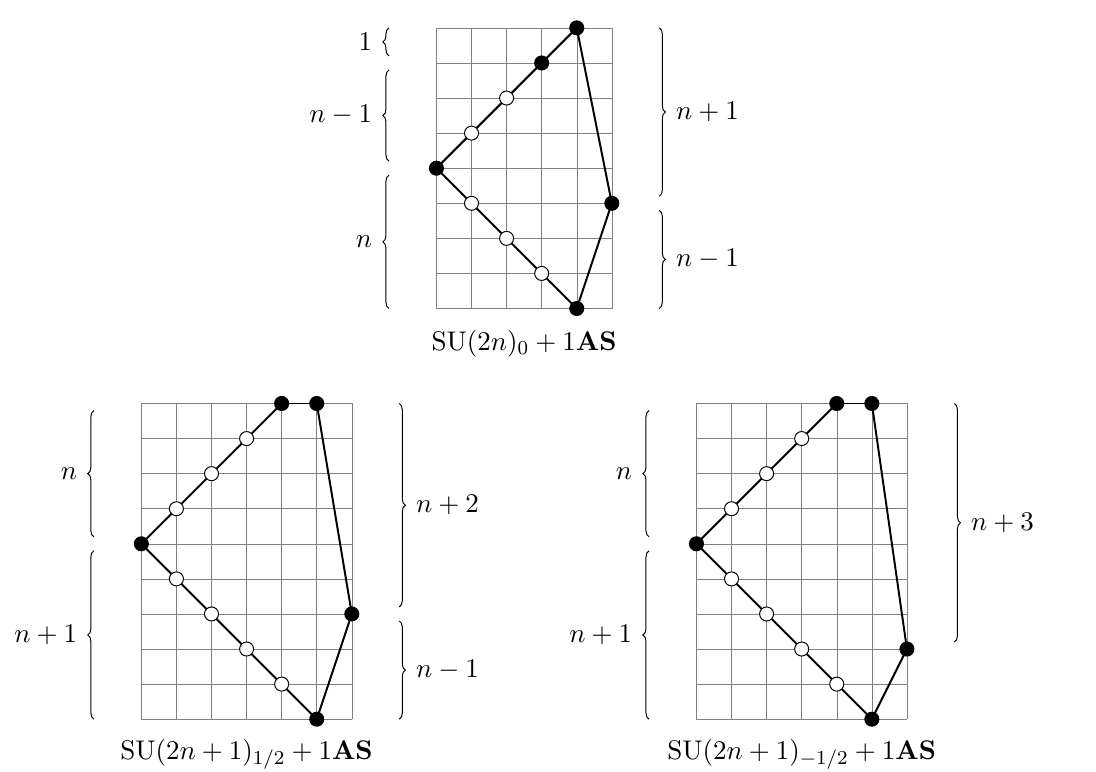
Figure 2 . Toric polygons for SU( N ) k + 1 AS for the lowest possible values of the Chern-Simons level, | k | < 1 . We have to distinguish between the cases where N = 2 n is even and N = 2 n + 1 is odd. The polygons presented here can be deduced from the brane webs constructed in [77]. The integers next to the braces indicate the vertical length of the corresponding segment; for the drawings we picked n = 4 . The Chern-Simons level can be increased / decreased by one unit by moving the rightmost dot upwards / downwards by one unit of